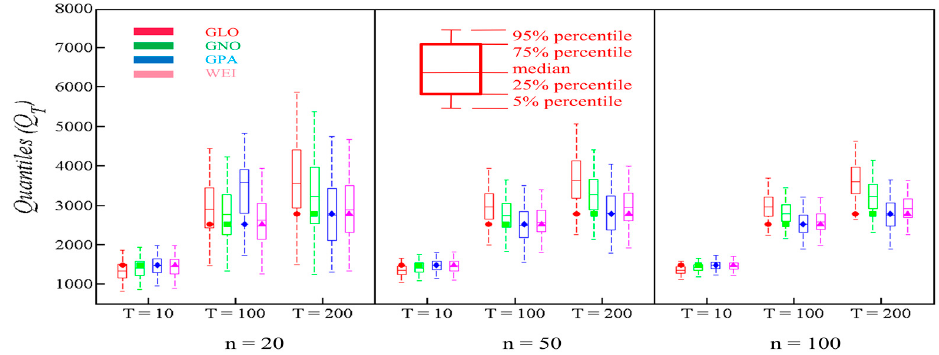
Figure 4. Boxplot for GLO, GNO, GPA and WEI for Panjkora river.